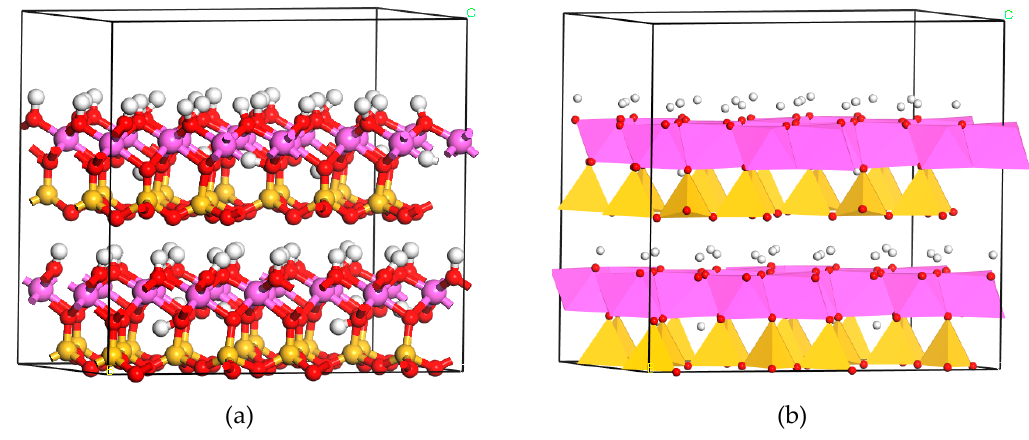
Figure 1. Model for of crystal structure kaolinite. White ball: H; red ball: O; purple ball: Al; yellow ball: Si. ( a ) Ball-and-stick model; ( b ) Polyhedron model.